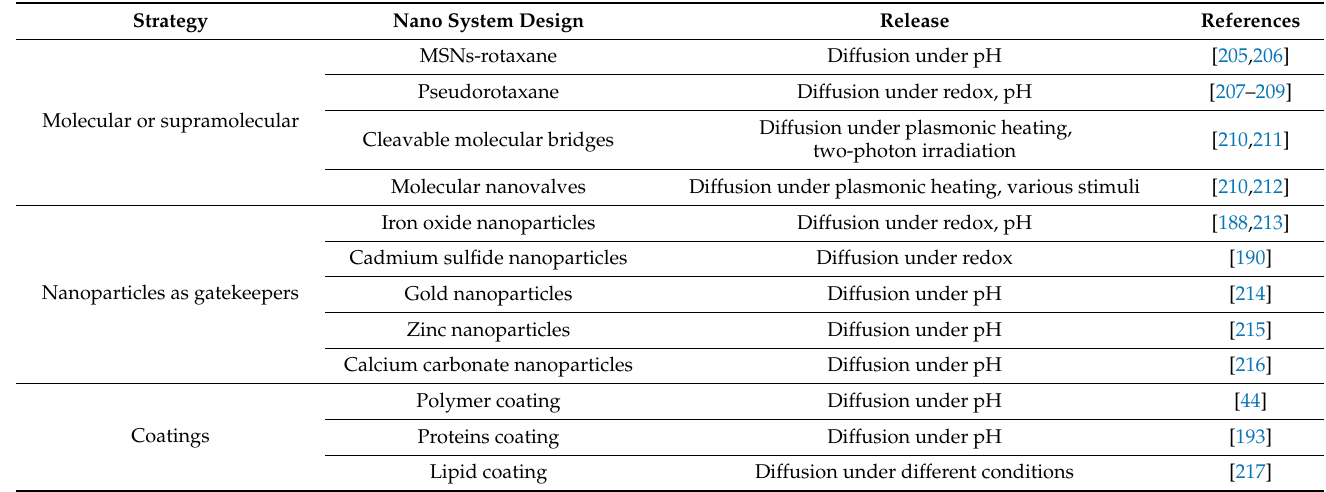
Table 6. Different loading strategies and their relationships to stimuli release under various conditions for MSNs.